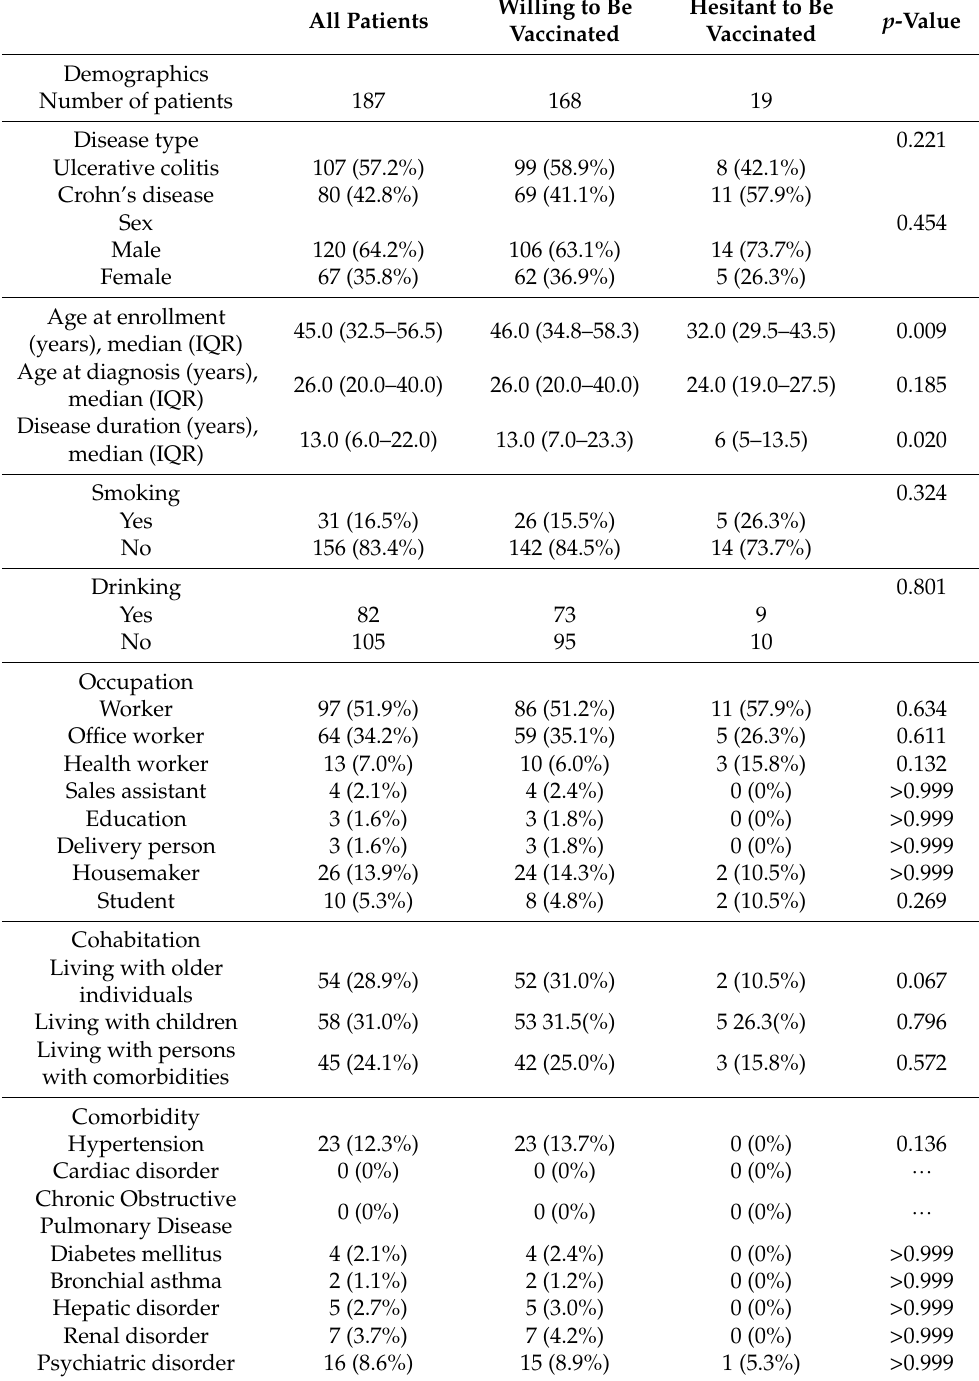
Table 1. Sociodemographic characteristics of the study participants by COVID-19 vaccination inten-